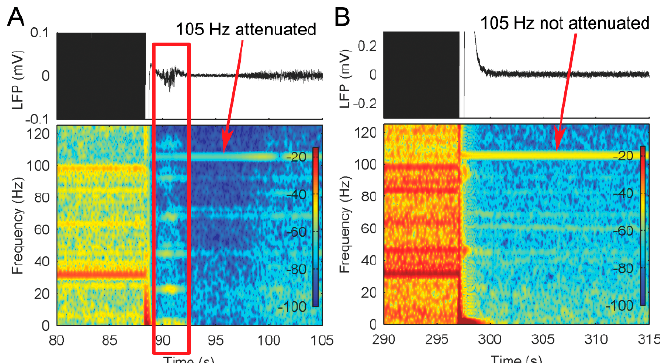
Figure 2. The use of a test tone to monitor the integrity of the bioelectric amplifier in measuring local field potentials (LFPs). ( A ) LFP measurement using an amplifier with a gain of 2000. The line box illustrates an example of distortion of signals induced by the amplifier recovering. ( B ) LFP measurement using an amplifier with a gain of 250.